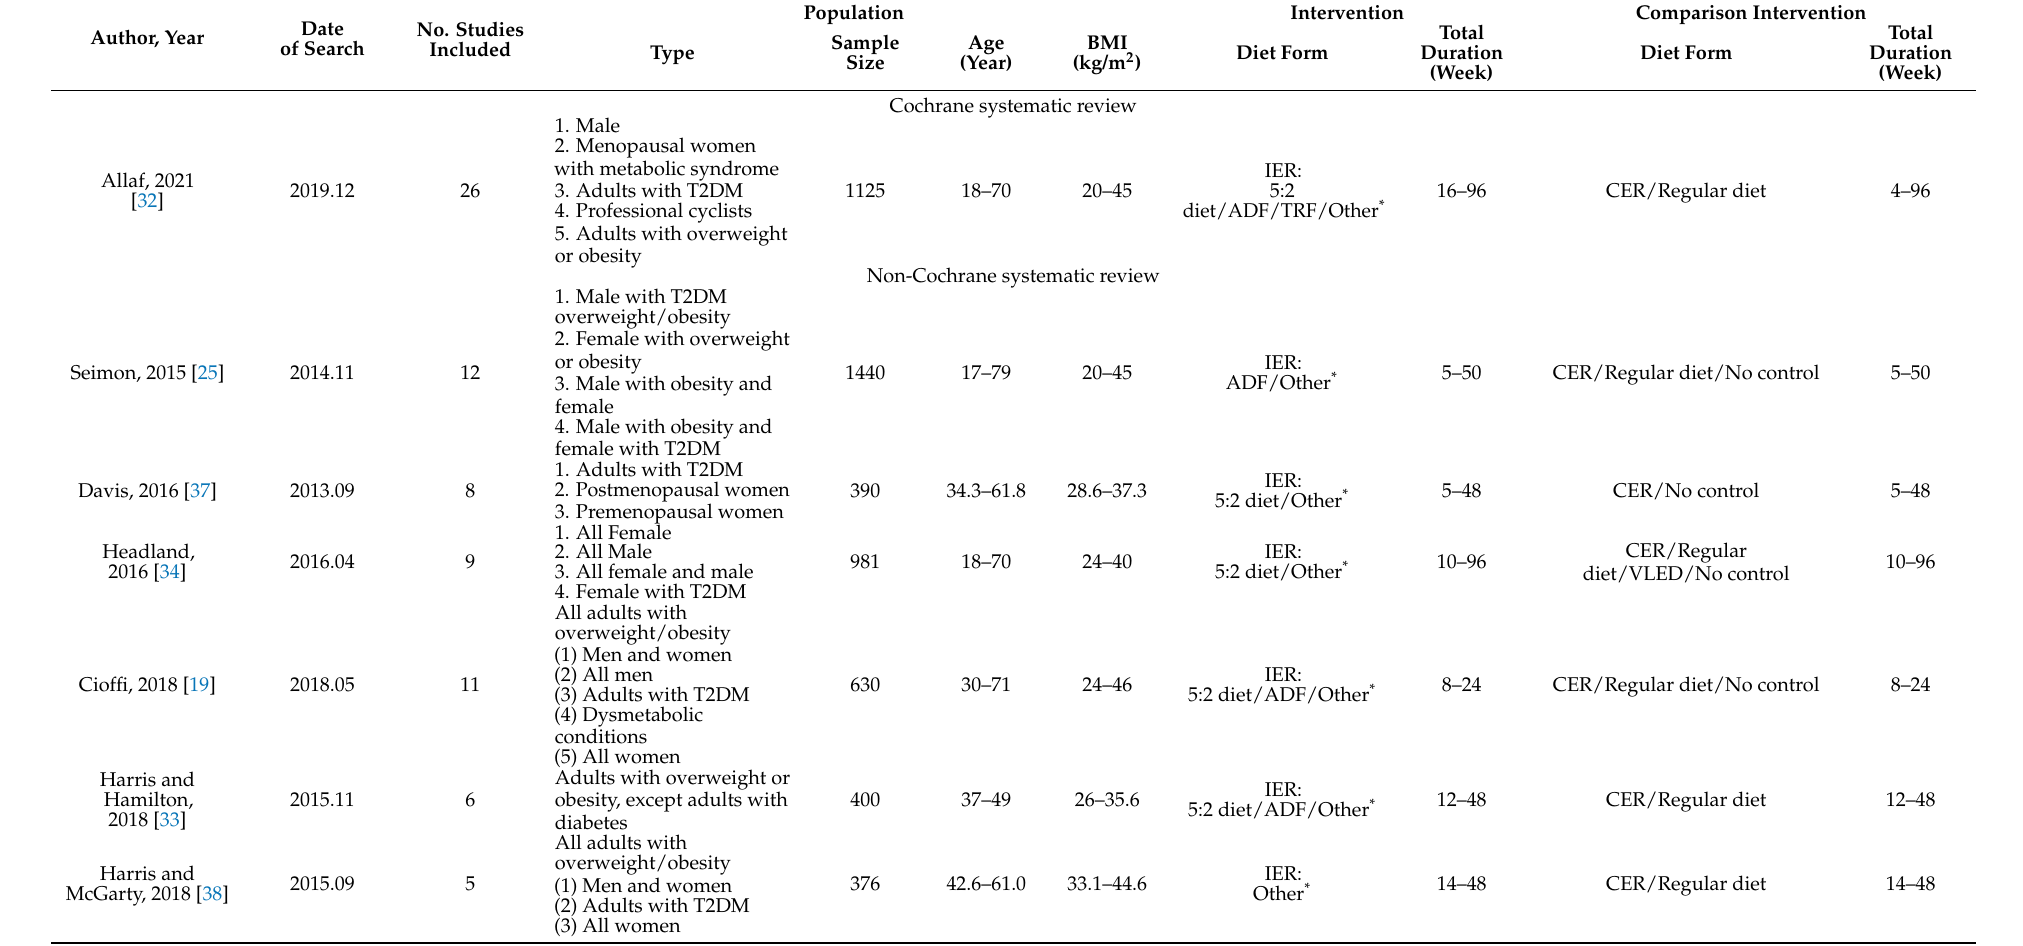
Table 1. Characteristics of included